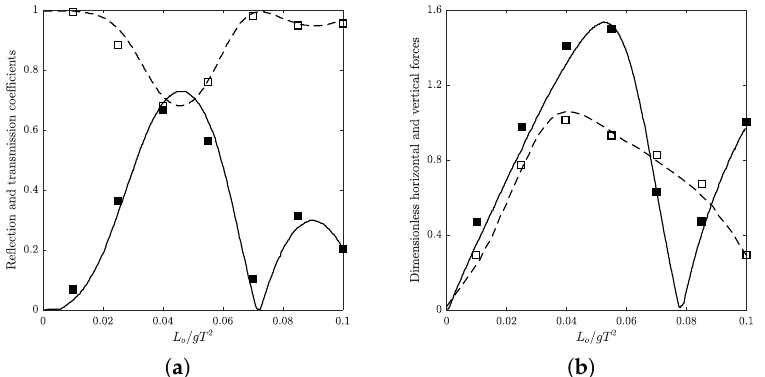
Figure 5. Wave scattering by a submerged obstacle above a solid bed: ( a ) reflection ( (cid:4) ; solid line) and transmission ( (cid:3) ; dashed line) coefficients; ( b ) dimensionless horizontal ( (cid:4) ; solid line) and vertical ( (cid:3) ; dashed line) forces acting on the obstacle, as defined in (2) and (3), respectively. Symbols: numerical simulations. Lines: analytical results reported in the literature [11]. In this case, ( d , D o , d (cid:96) , d m ) = ( 0.8,0.02,0.54,0 ) m and the incident wave period is T = 1.79 s. See Figure 1c for the problem sketch.